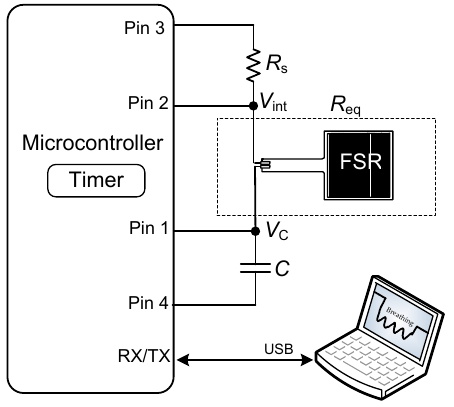
Figure 3. DIC applied to measure the FSR with a smart wake-up.